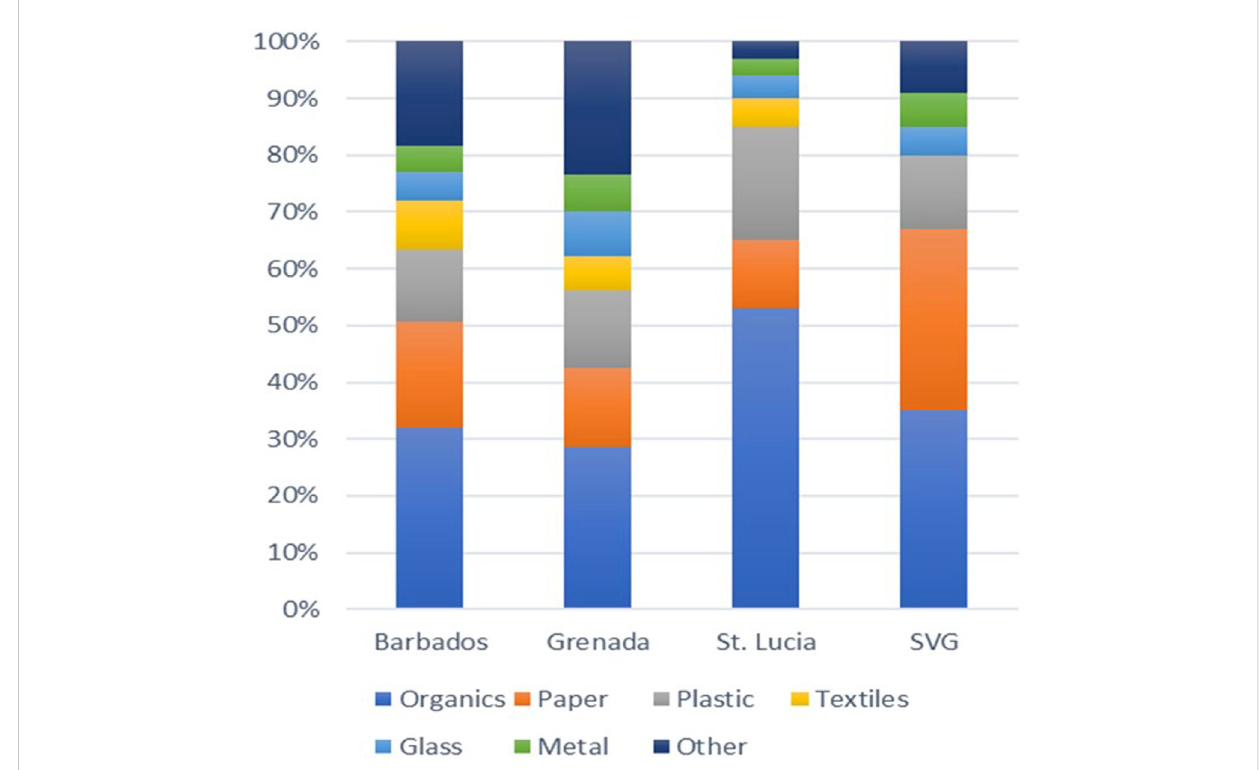
FIGURE 3 Waste Characterisation for Windward Island nations of Barbados (Government of Barbados, 2018), Grenada (Grenada Solid Waste Management Authority, 2019), St. Lucia (St. Lucia Solid Waste Management Authority, 2018) and SVG (Seadon et al., 2019). Percentages are based on the volume of waste (tonnes). Dominica is excluded due to the information being